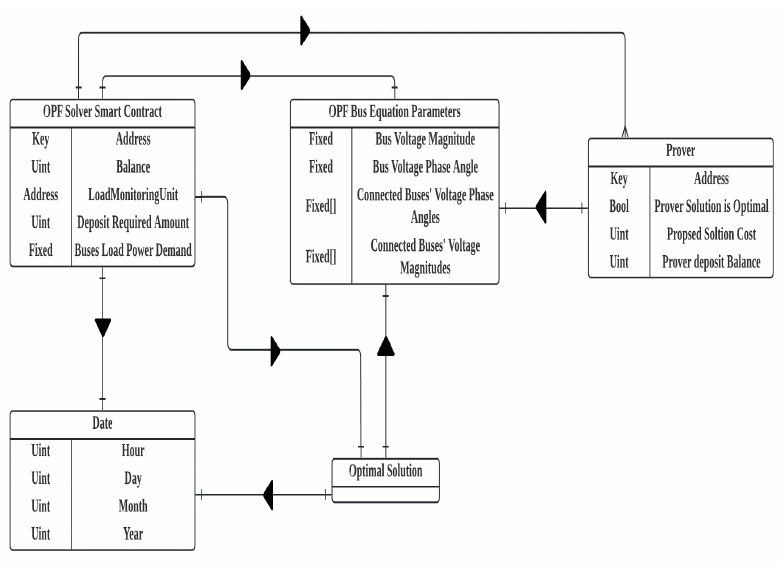
Figure 10. Entity-relationship diagram for the enhanced OPF solution